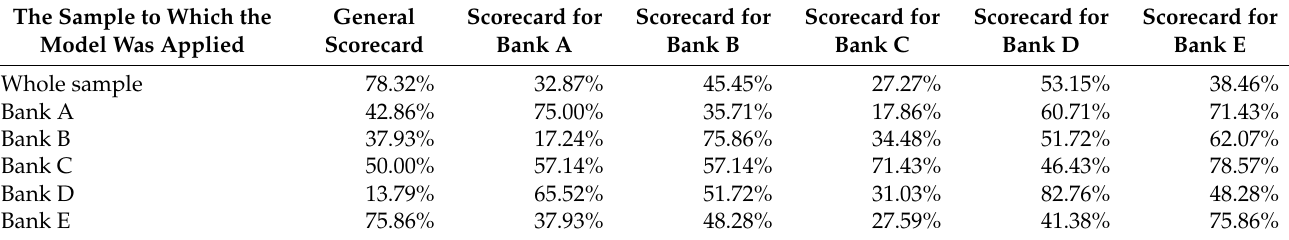
Table 15. Summary of the first efficiency level of the developed scoring models to evaluate customers in other banks. The Sample to Which